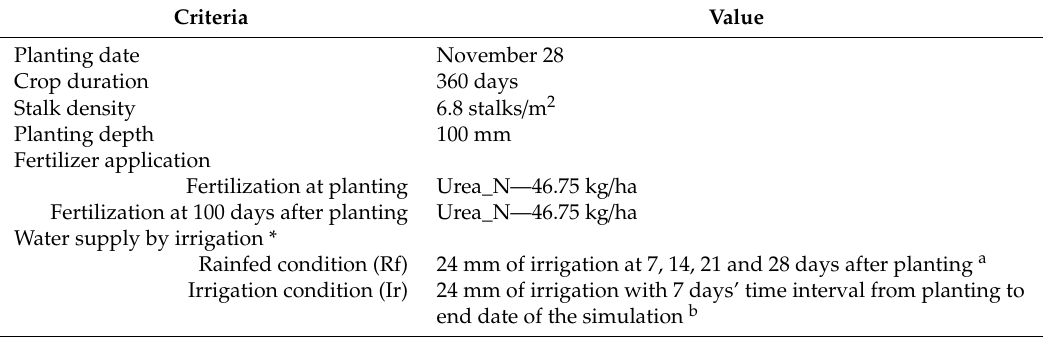
Table 2. Management conditions used for the Agricultural Productions System Simulator (APSIM)